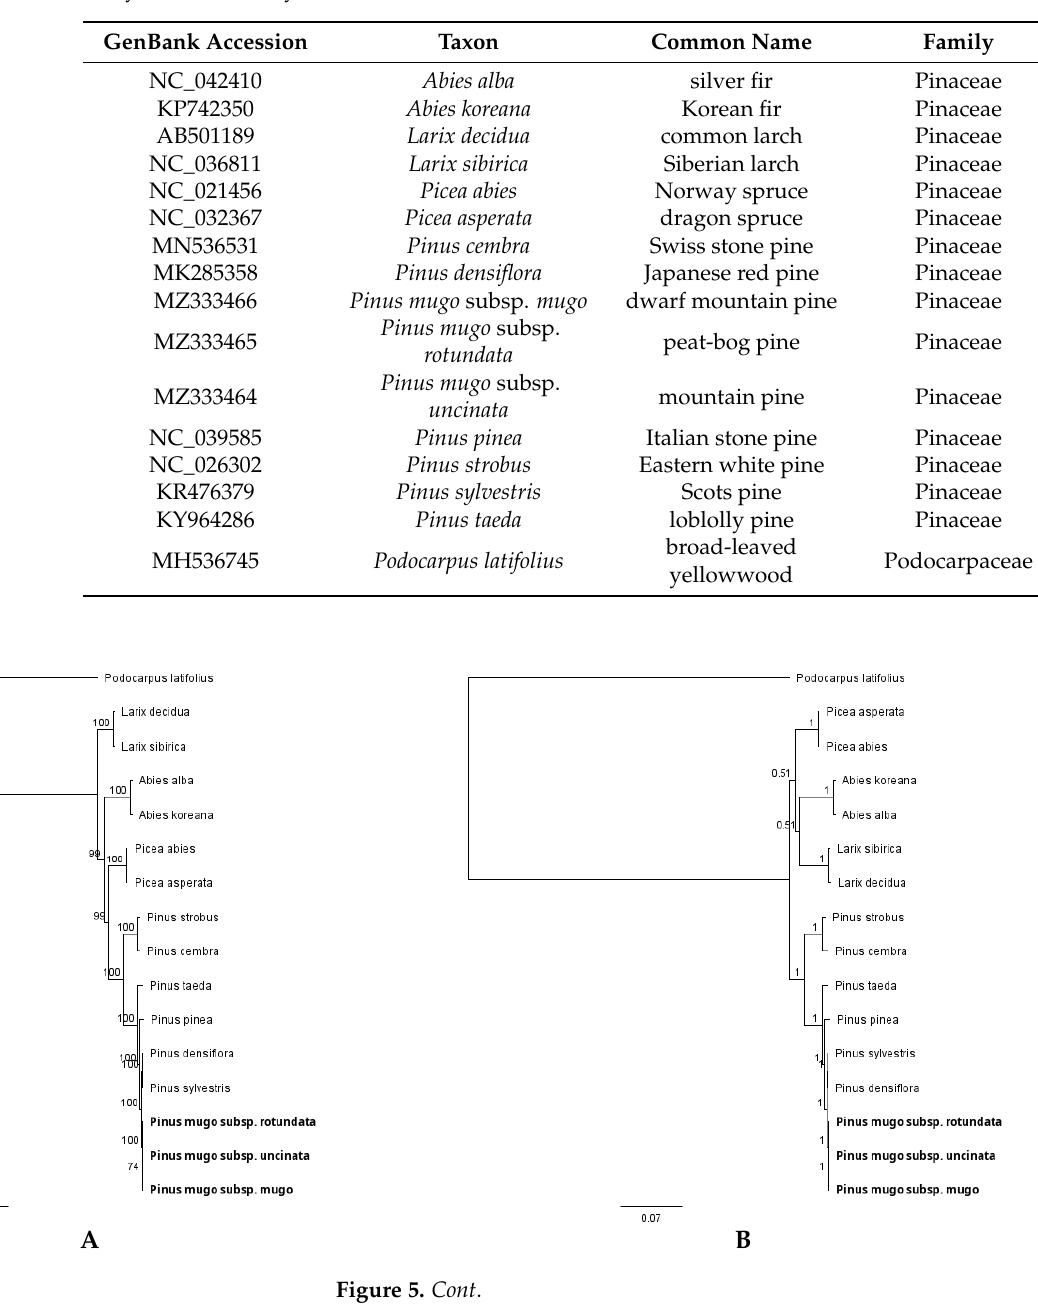
D Figure 5. Phylogenetic relationships between sixteen conifers taxa based on complete sequences of chloroplast genomes ( A ) and ( B ) inferred from ML and BI analyses, respectively, and only on ycf1 ( C ) and ( D ) also inferred from ML and BI analyses, respectively. 3. Materials and Methods 3.1. Sampling, DNA Extraction and Genomic Library Preparation Fresh and healthy needles of the three most recognized members of the Pinus mugo complex were collected as follows: Pinus mugo subsp. uncinata (hereinafter referred to for short as Pinus uncinata) (collection number 1347) from the Dendrological Garden of Uni- versity of Life Sciences, Pozna ń , Poland (52°25 ′ 37 ″ N, 16°53 ′ 48 ″ E); Pinus mugo subsp. ro- tundata (hereinafter referred to for short as Pinus rotundata ) from the Great Peat Bog of Batorów located in Sto ł owe Mountains National Park, Poland (50°15 ′ 42.48 ″ N, 16°8 ′ 31.92 ″ E) and finally Pinus mugo subsp. mugo (hereinafter referred to for short as Pinus mugo ) from the Tatra National Park (UNESCO Biosphere Reserve), Poland (49°10 ′ 0 ″ N, 19°55 ′ 0 ″ E). The collected needles were stored at 4 °C, until DNA extraction. Genomic DNA was isolated using the CTAB method [64]. The quality and integrity of isolated DNA were